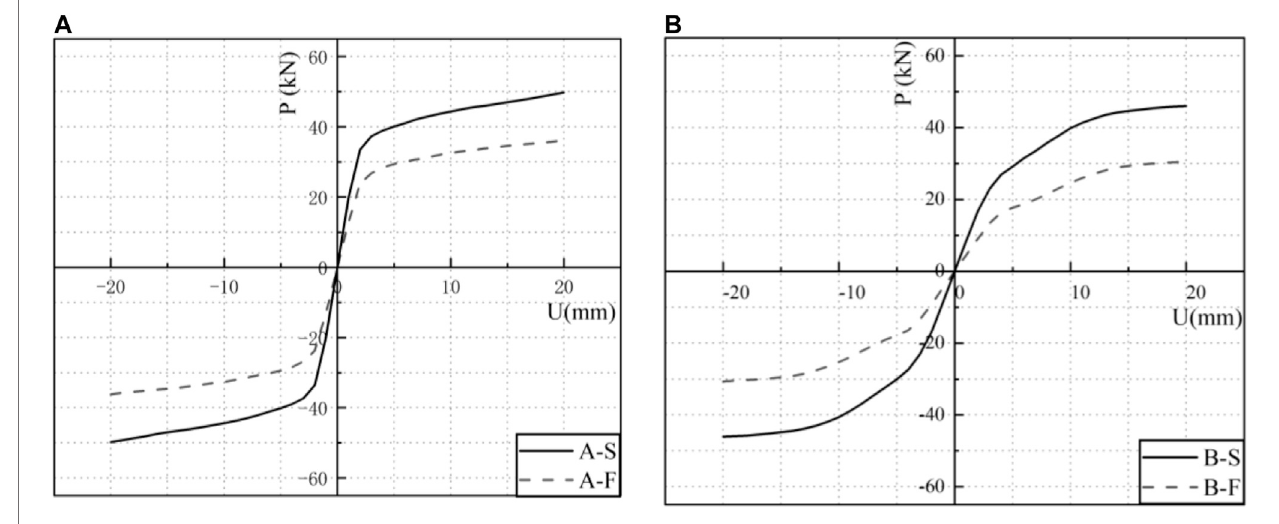
FIGURE 13 | The skeleton curve of the damper.